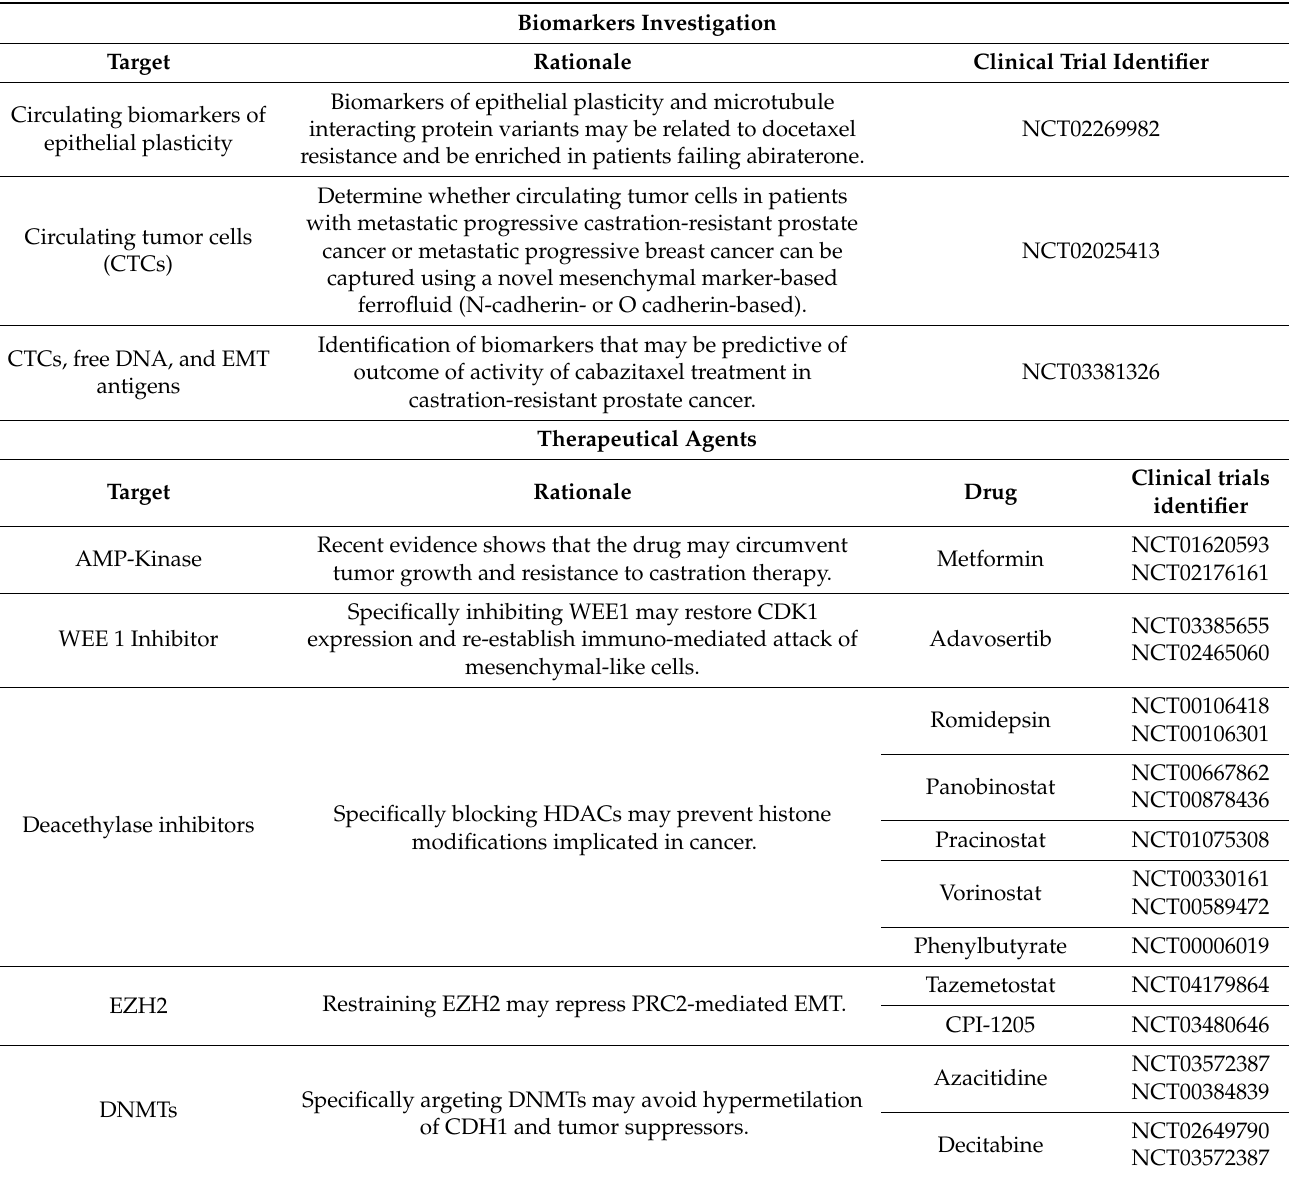
Table 2. EMT-targeting clinical trials in